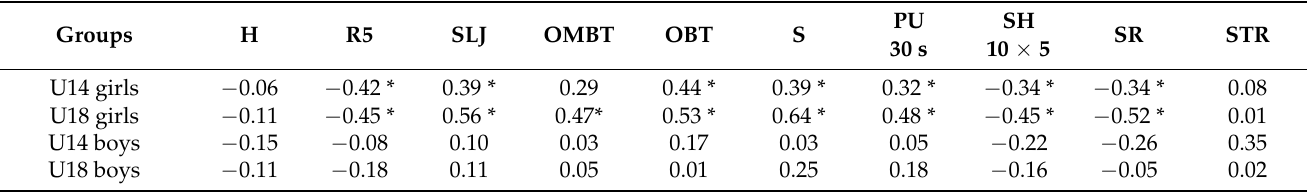
Table 5. Spearman correlation coefficients between physical variable of selected field tests and the current competitive performance in elite junior tennis players ( n =